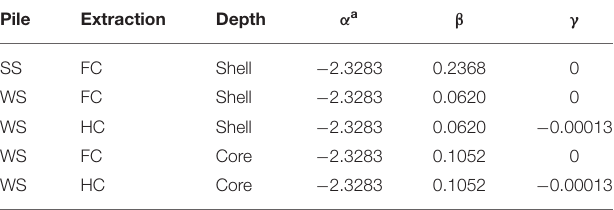
TABLE 8 | Coefficients of model 1 to estimate the dry matter Loss (DML) in a summer storage (SS) pile and a winter storage (WS) pile of freshly harvested willow chips (FC) and hot water extracted willow chips (HC).